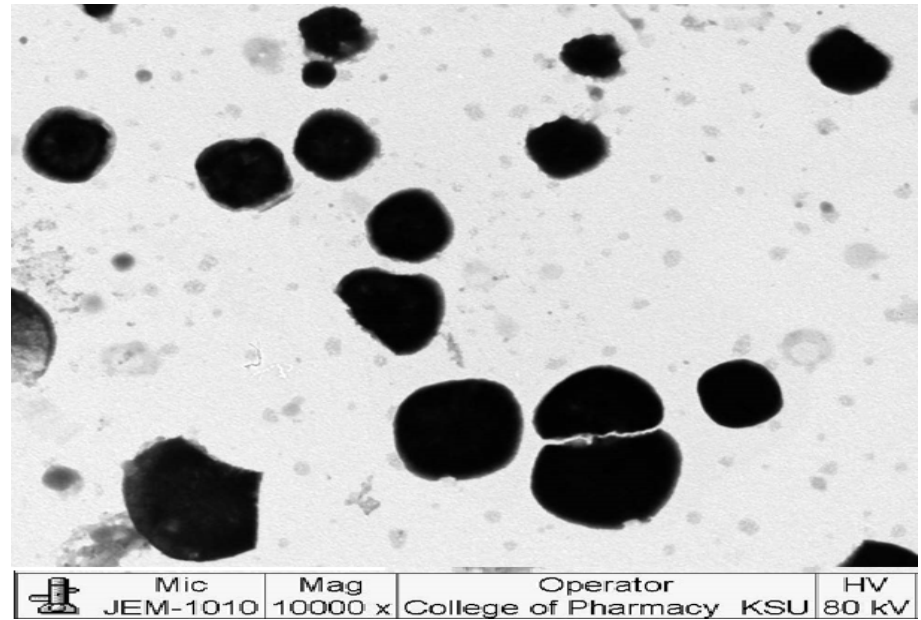
Figure 4. TEM image of the selected formula.